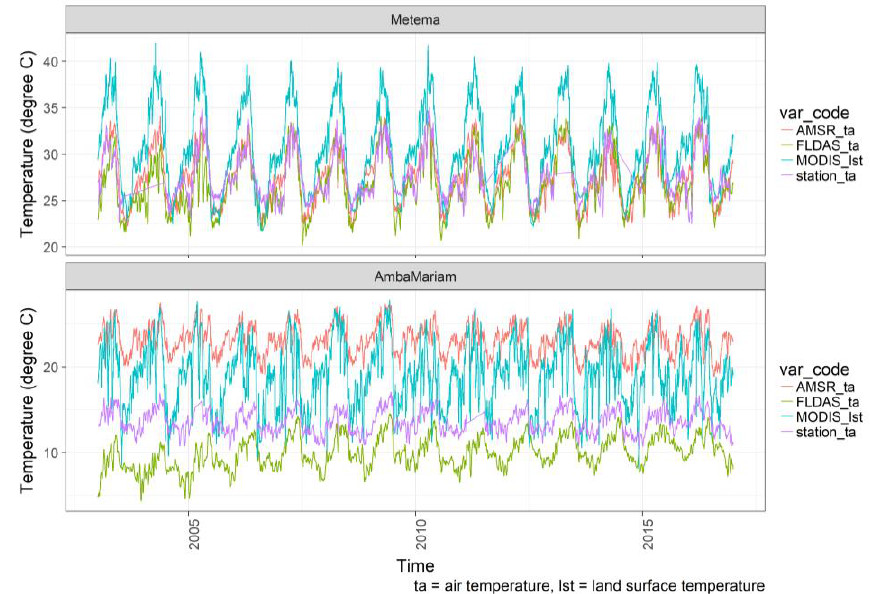
Figure 6. Time series plot of temperature from remote sensing satellite (AMSR air temperature (ta) and MODIS LST), interpolated (FLDAS ta), and meteorological station (station ta) datasets at a lowland (Metema), and highland (Amba Mariam) stations, Northwest Ethiopia, for 2003–2016. Note the y-axis scale difference.